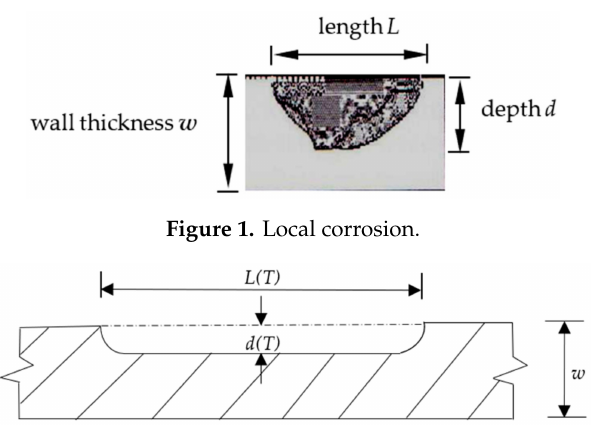
Figure 2. The profile of pipeline with ideal corrosion